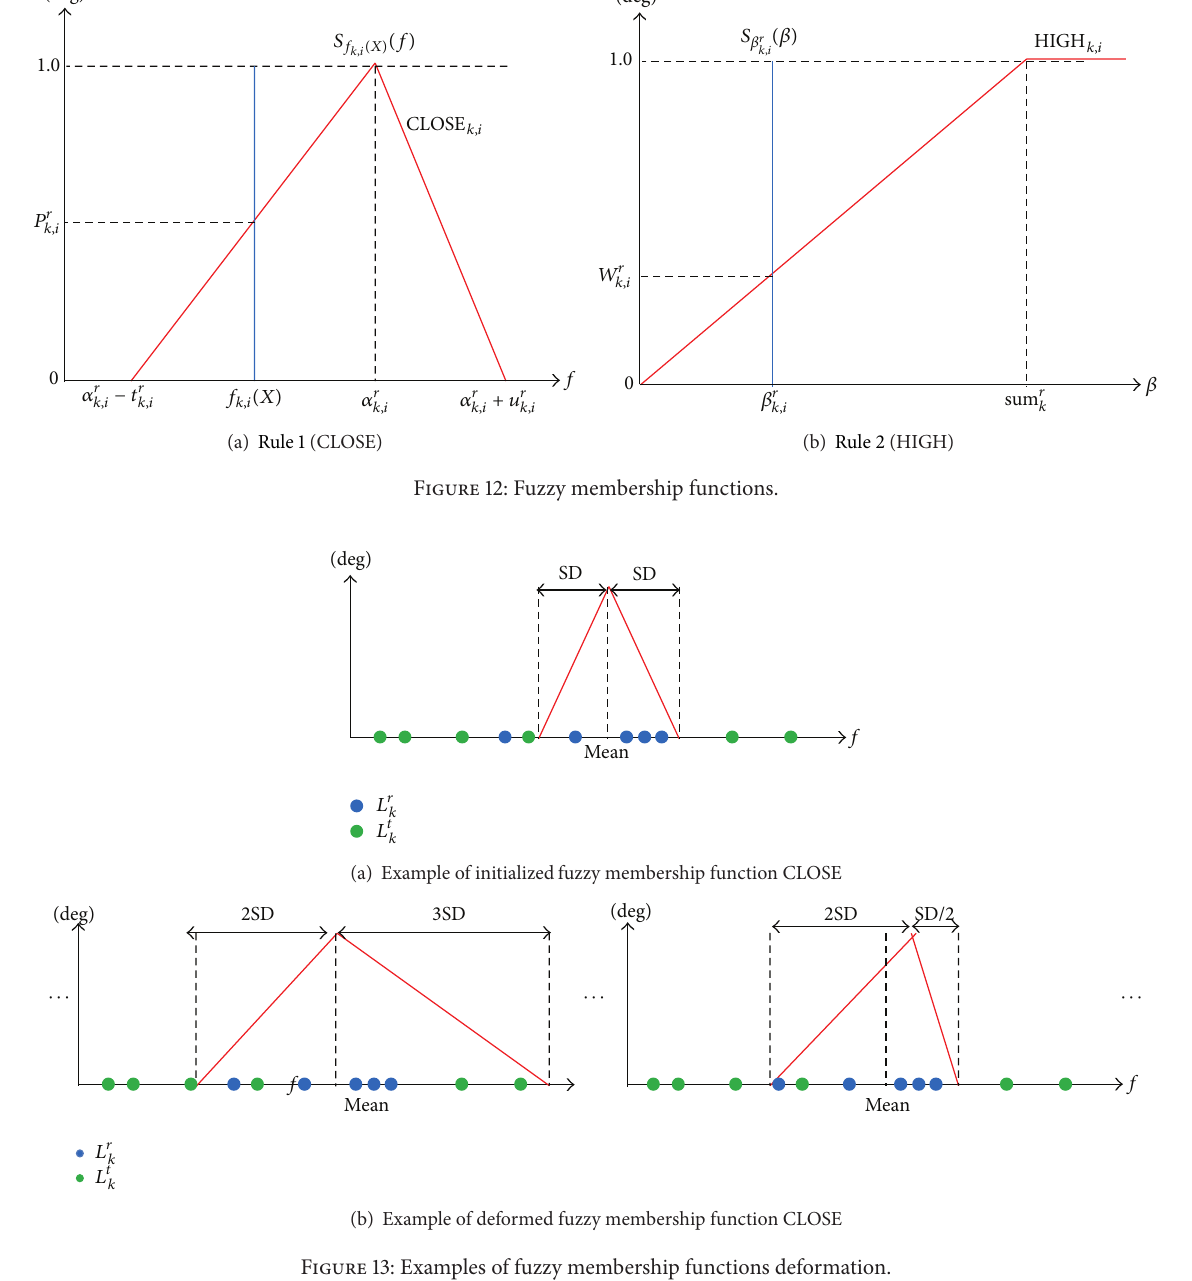
Figure 13: Examples of fuzzy membership functions